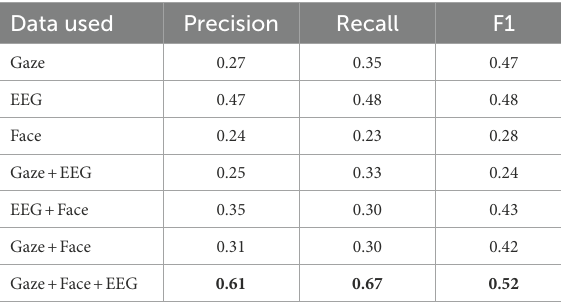
TABLE 3 Emotional engagement prediction results. Data used